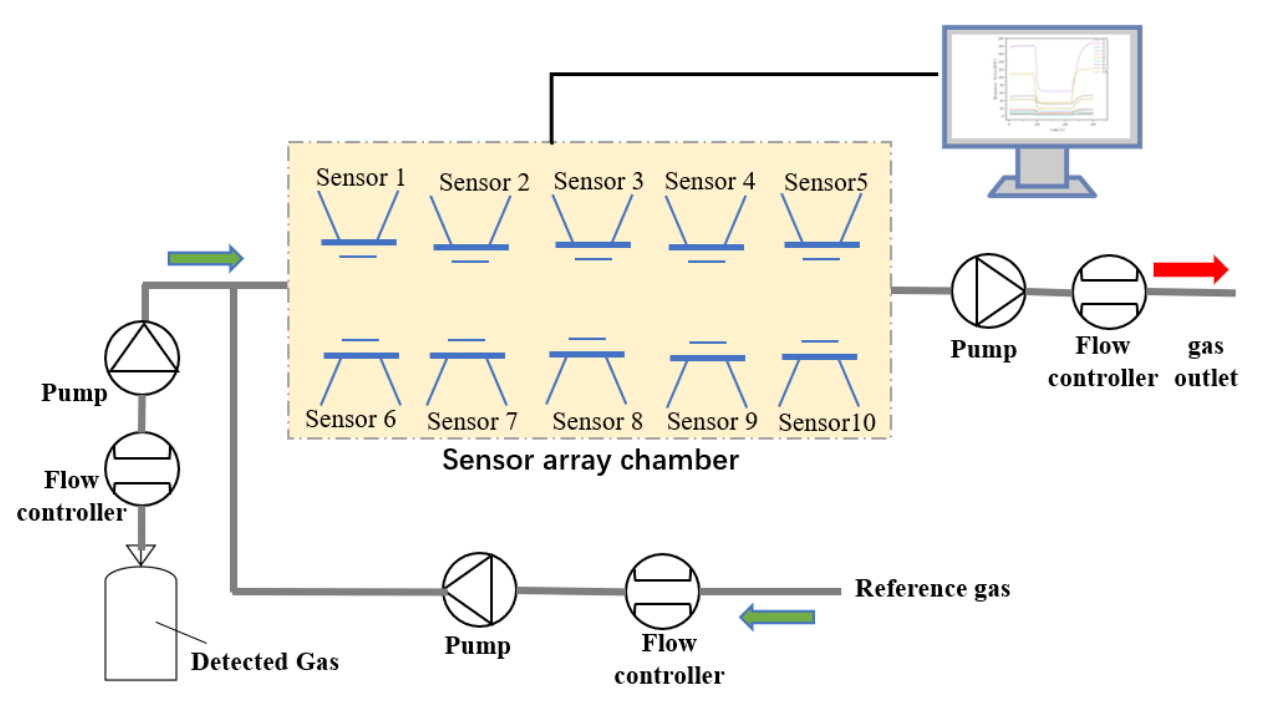
Figure 1. Schematic diagram of the experimental E-nose system. Table 1. Characteristics of the employed gas sensors in initial sensor array. Sensor No.